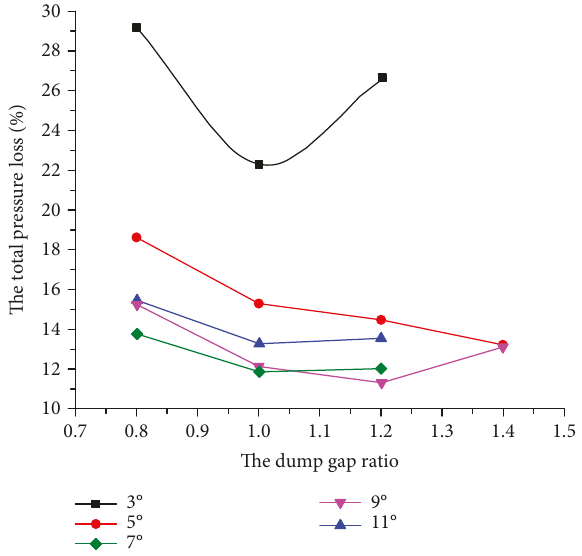
Figure 23: Relationship between the total pressure loss and the dump gap ratio with varieties of predi ff user expansion